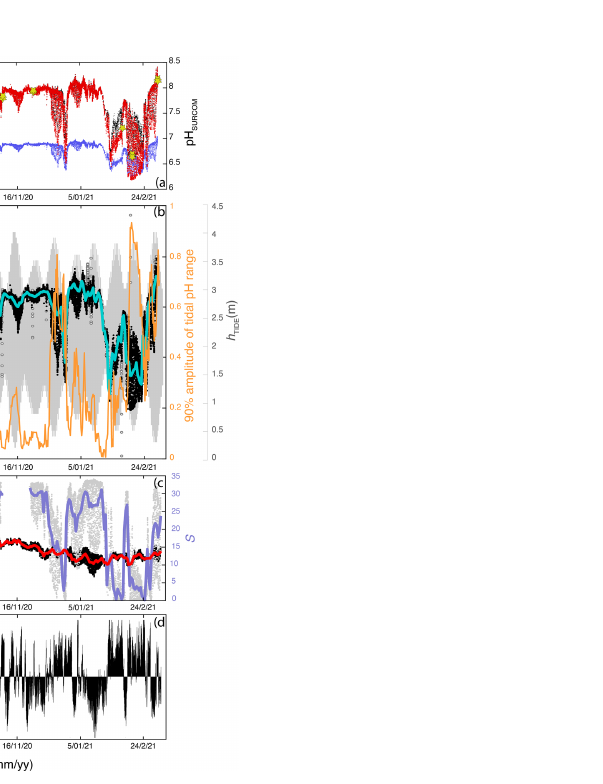
FIGURE 6 Time series of measurements with a frequency of 10.5 minutes gathered from July 8, 2020 to March 6, 2021 at the mooring station. (A) raw voltages from SURCOM (blue dots), raw SURCOM pH (red dots), calibrated SURCOM pH (black dots) and pH values of discrete samples used for calibration (yellow stars). (B) pH calibrated values from SURCOM (black dots) and outliers (white dots) after pH quality control. The daily mean calibrated pH values (cyan line), the tidal height (gray line) and the pH range between the 5 th and 95 th percentile during each tidal cycle (orange line) are also plotted. (C) Temperature measured by the SURCOM sensor (black dots) and salinity (gray dots) obtained with a CTD instrument at a depth of 1 meter in same mooring line. The daily mean temperature (red line) and salinity (blue line) are also shown. (D) Meridional component of wind speed V